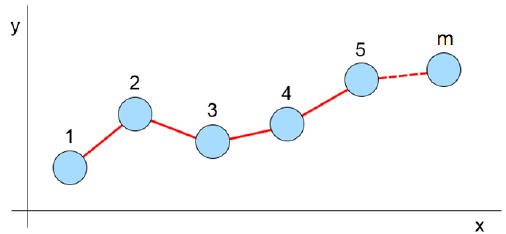
Figure 4. A single-row structure of the Kohonen layer.